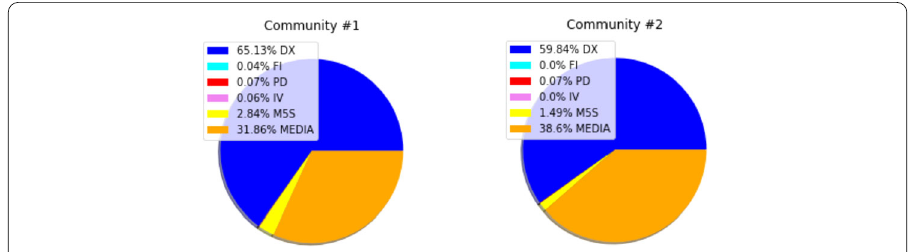
Figure 8 Discursivecommunitiesandsemanticconspiracycommunities . In the plots the number of times users of the discursive communities have published a hashtag belonging to the two different communities